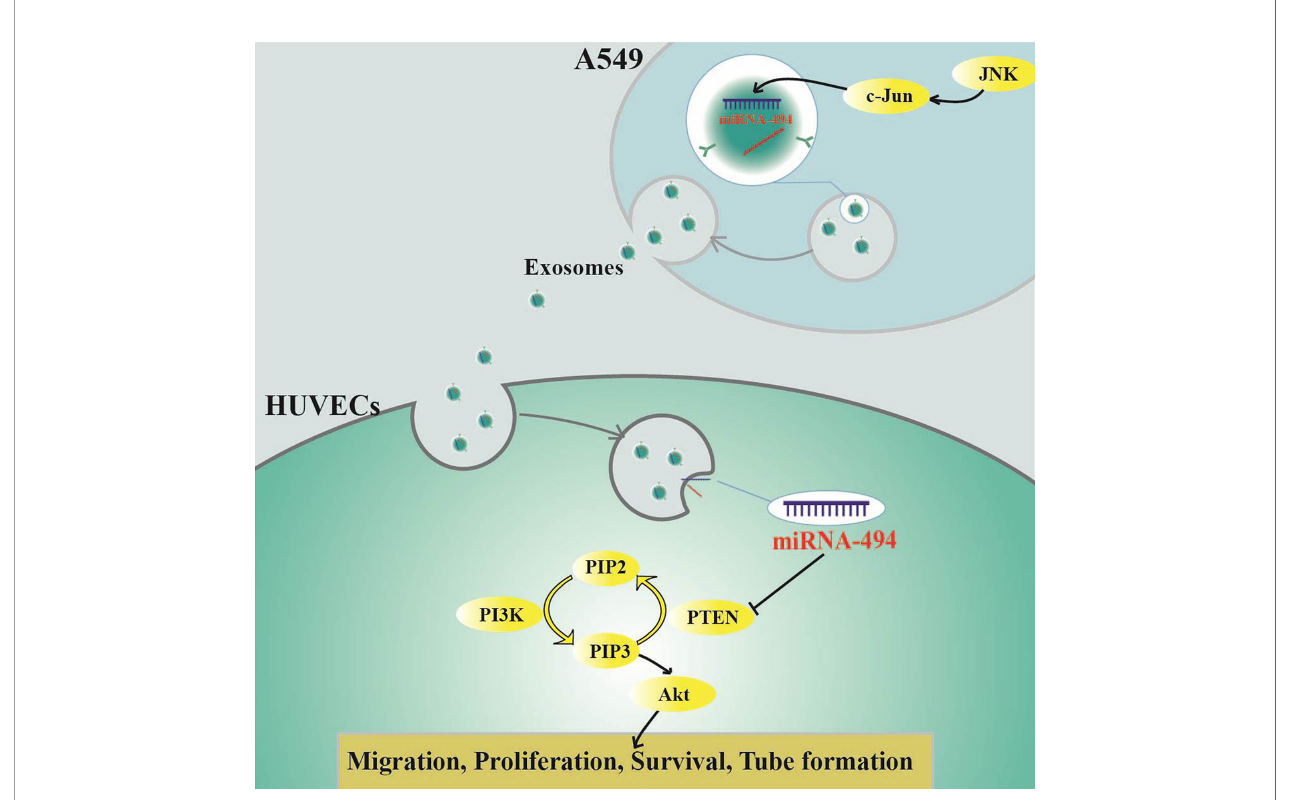
FIGURE 6 | Schematic diagram indicating how c-Jun affects angiogenesis in HUVECs through exosome/miR-494/PTEN signal